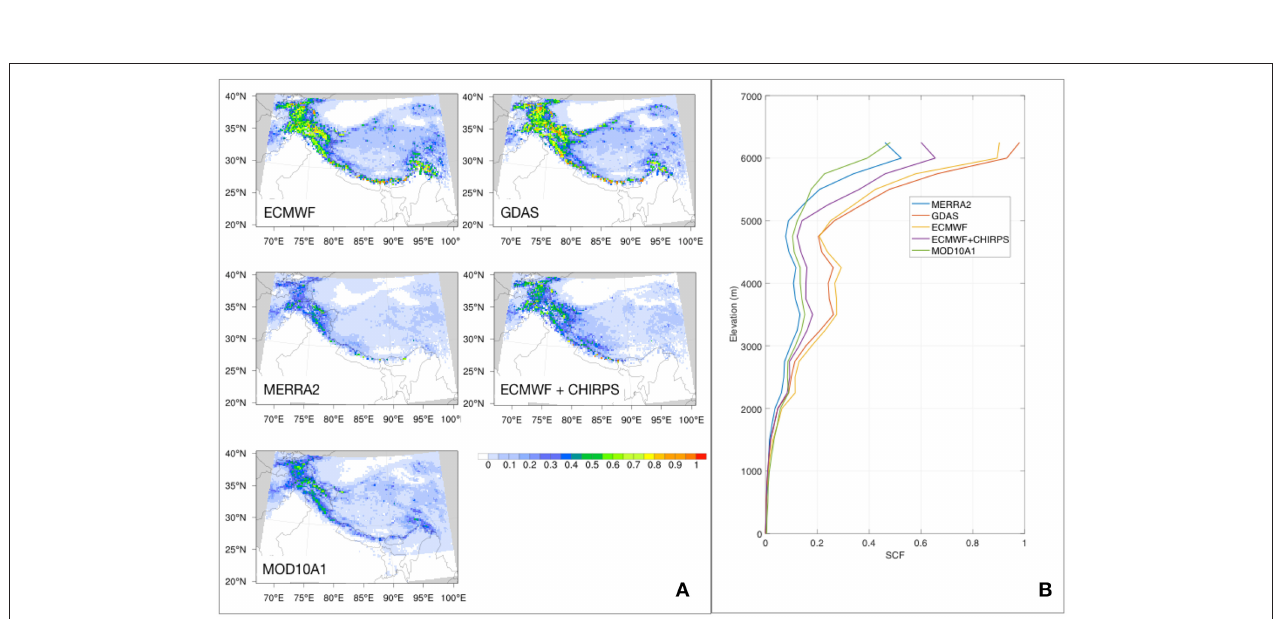
FIGURE 12 | Comparison of mean SCF estimates (unitless) from MOD10A1 and the model runs. (A) Shows the spatial maps of mean SCF whereas (B) shows the domain-averaged SCF stratified by elevation. The modeled estimates are averaged across the three LSMs for each forcing data.